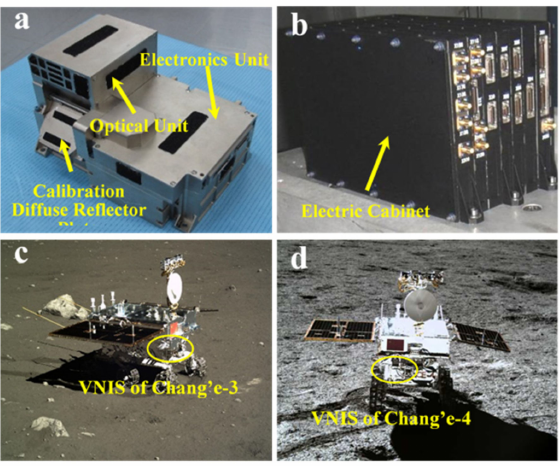
Figure 1. The probe composition of VNIS ( a ) and its electric cabinet ( b ); installation location of VNIS on the rover for the Chang’e-3 ( c ) and Chang’e-4 ( d ) missions. VNIS contains two measurement channels, the visible and near-infrared (VIS-NIR 480–950 nm) and the shortwave infrared (SWIR 900–2400 nm). VIS-NIR is the imaging channel, and SWIR is the spectral acquisition channel. The VNIS on board Chang’e-3 has a spectral resolution of 2–7 nm in the VIS-NIR band and 3–12 nm in the SWIR band [29]. The VNIS on board Chang’e-4 has an improved spectral resolution of 2.4–6.5 nm in the VIS-NIR band and 3.6–9.5 nm in the SWIR band. The two channels have a field of view (FOV) of 8.5 × 8.5 ◦ and ø3.6, the measurement distance is 0.7 to 1.3 m, and the instrument can observe targets within 0.2 m 2